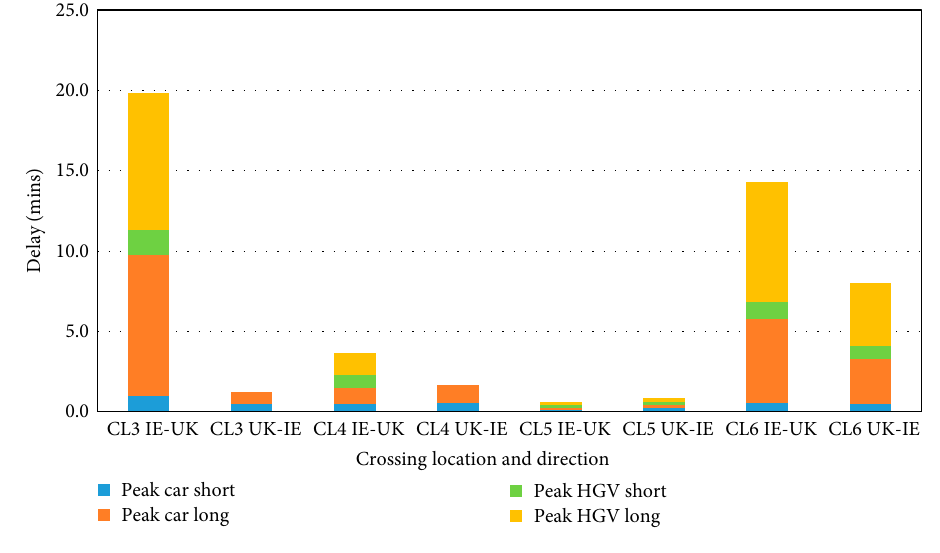
Figure 6: Delay at crossings by scenario.